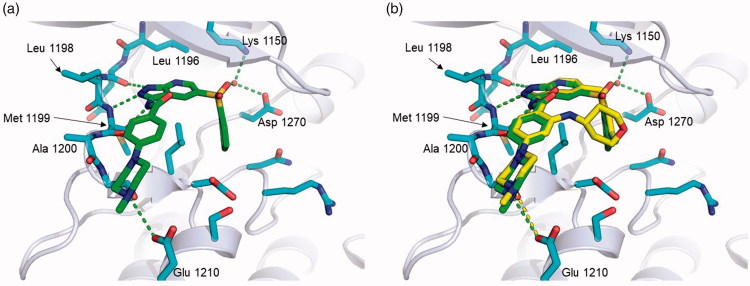
The predicted binding mode (a) of 10g (carbon in green) based on an X-ray crystal structure (PDB code: 5FTO) is superimposed (b) to the X-ray binding mode of entrectinib (carbon in yellow).